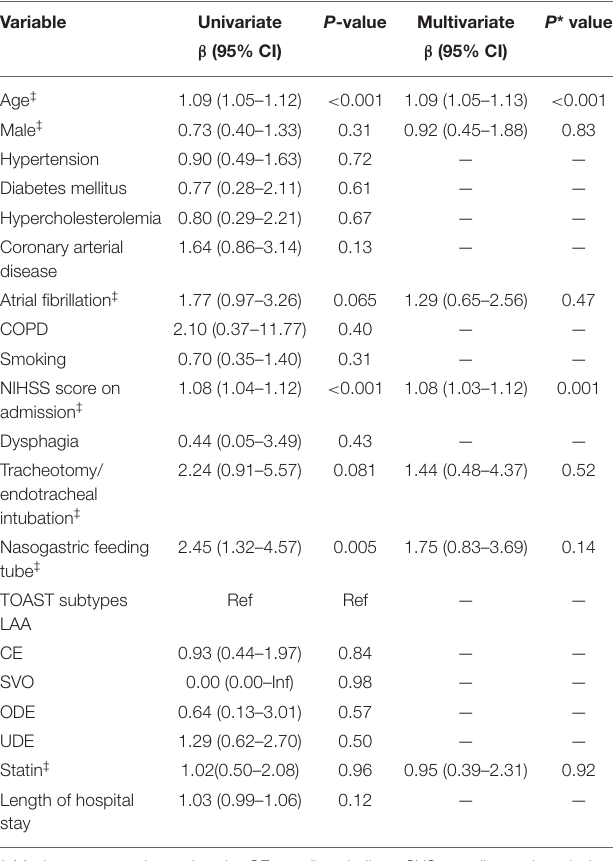
TABLE 4 | Univariate and multivariate logistic regression analysis for severe post-stroke pneumonia (CURB-65 score ≥ 3).